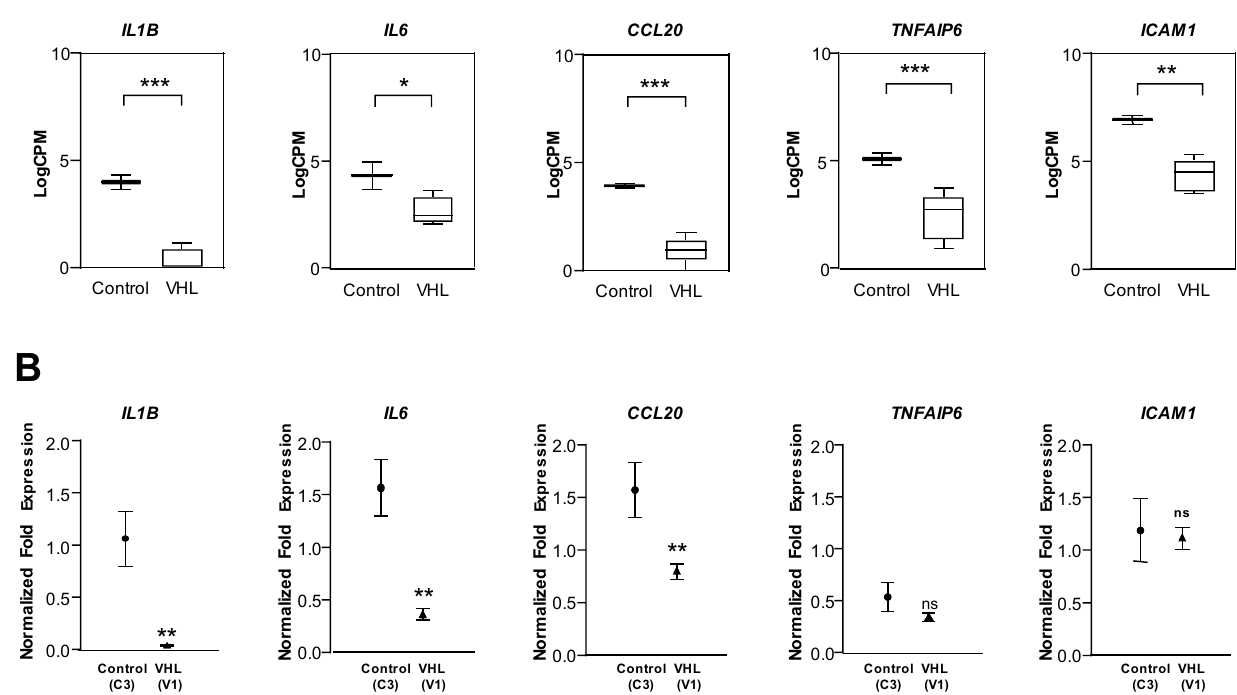
Figure 4. RNAseq validation for different genes involved in the inflammatory response: IL1B , IL6 , CCL20 , TNFAIP6 , and ICAM1 . ( A ) RNAseq results of primary cultures derive from ECs from control ( n = 2) and VHL patients ( n = 5) . ( B ) qPCR results derived from RNA samples obtained from controls ( n = 2) and VHL primary cultures ( n = 3) of ECs. The results shown are representative of three independent experiments. Error bars denote ±SEM. Student’s t -test: * p < 0.05; ** p < 0.01; and *** p < 0.001.